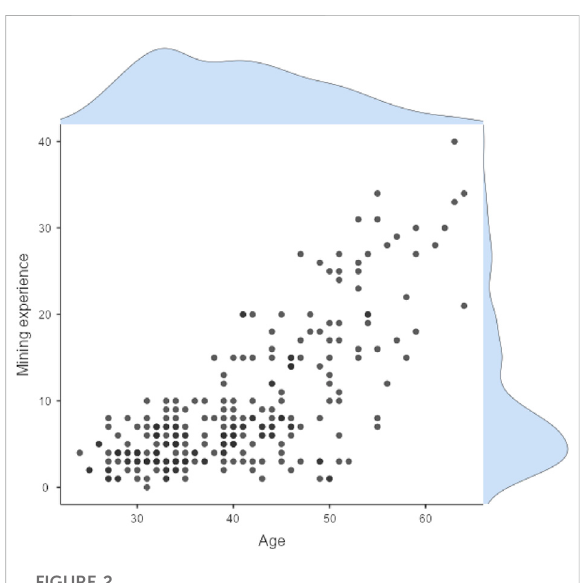
FIGURE 2 Distributionsand therelationship between age and